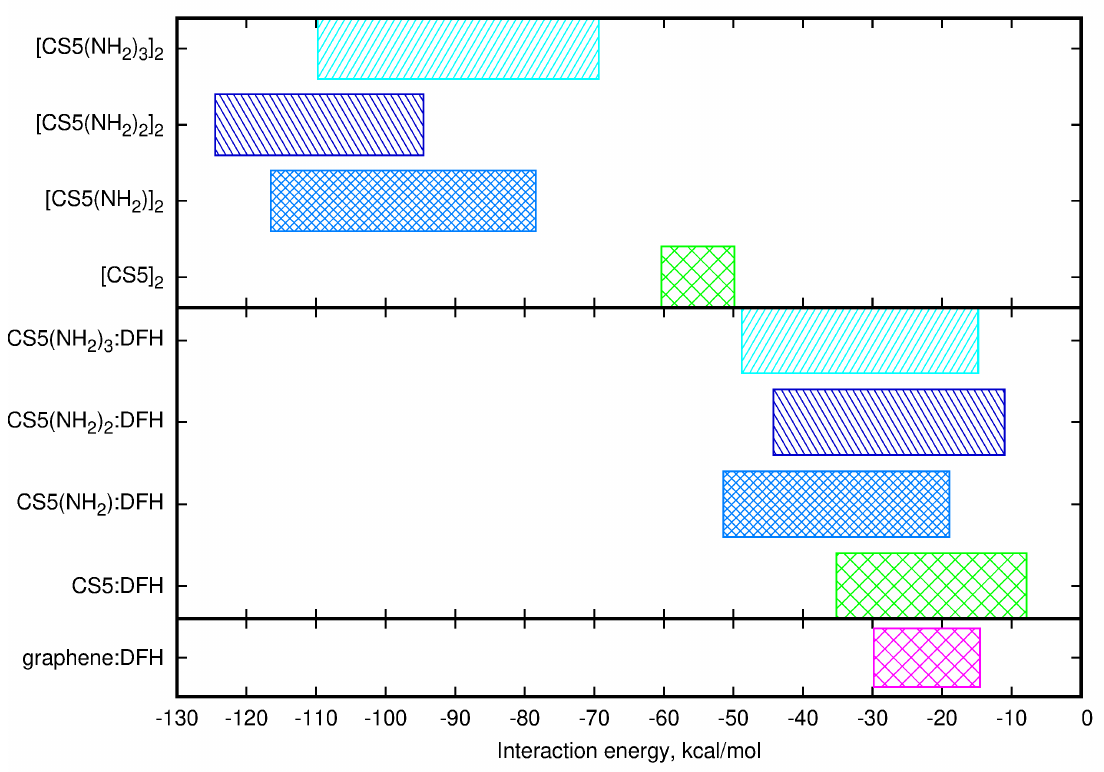
Figure 18. Supermolecular interaction energy ranges for chitosan dimers (upper panel), diclofenac:chitosan (middle panel) and diclofenac:graphene complexes [61] (lowest